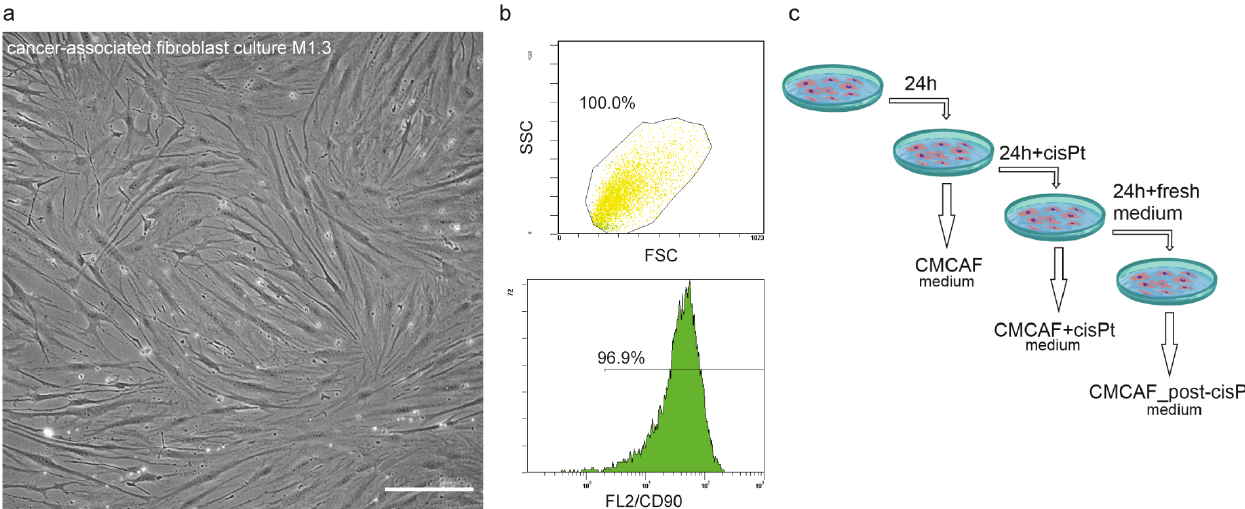
Figure 1. Preparation and characterization of cancer-associated fibroblasts (CAFs) and CAF-conditioned media. ( a ) Representative phase-contrast image of CAF culture, 20 × magnification, scalebar indicates 100 µ m. ( b ) Verification of fibroblast phenotype by CD90 status. Forward scatter and side scatter population (top) and FL2 histogram. ( c ) Scheme of CAF-derived conditioned media preparation for indirect coculture experiments. After the cells (CAFs) reached optimal confluence, their culture media were replaced with fresh media. After 24 h the conditioned media were collected (CMCAF) and replaced with media containing 5 µ M cisplatin. After 24 h the media were collected (CMCAF+cisplatin) and replaced with fresh media, which were collected after an additional 24 h